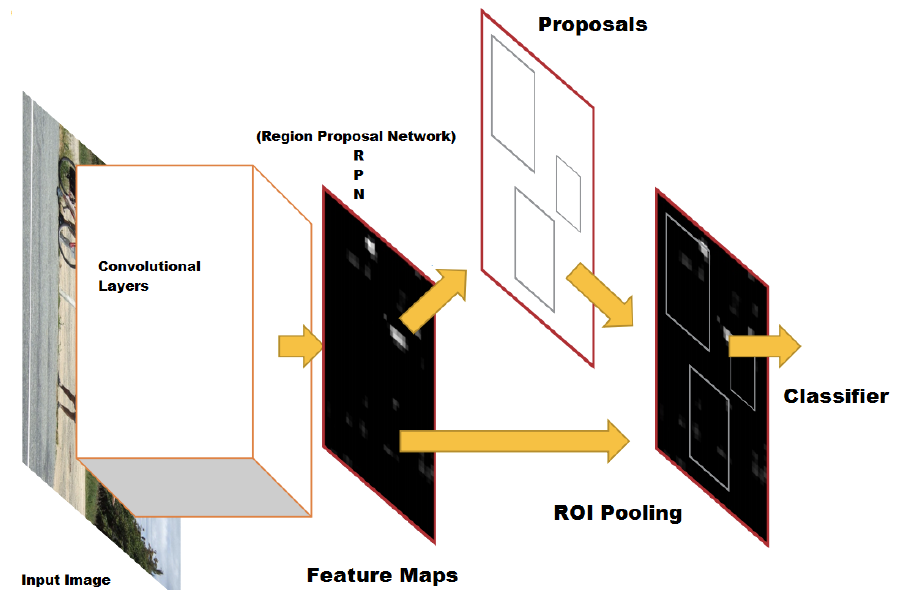
Figure 2. Faster-CNN architecture.